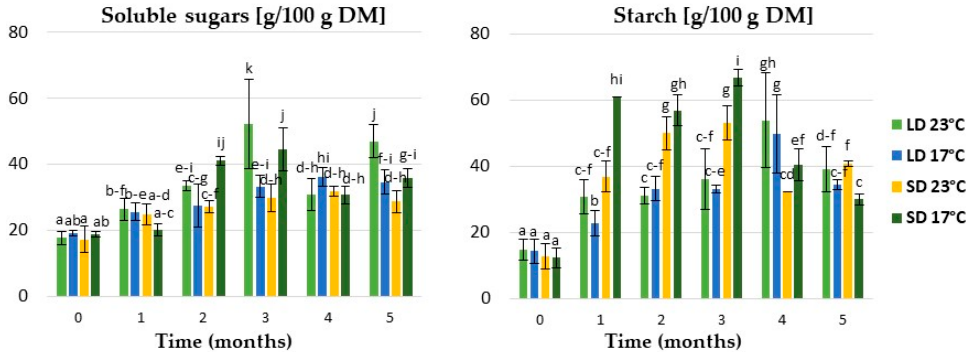
Figure 4. Variation in the content of soluble sugars and starch in rhubarb buds during five months of ex vitro growth under different temperatures (17 °C and 23 °C) and photoperiods (16 h and 10 h). According to Duncan’s test ( p = 0.05), means marked with the same letter do not differ significantly ( p = 0.05). Error bars represent standard deviation.